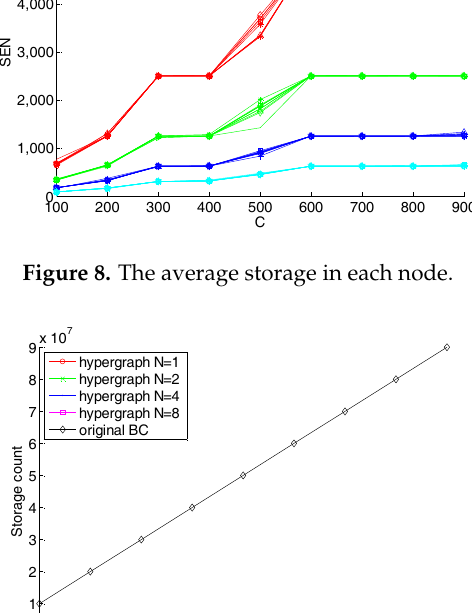
Figure 8. The average storage in each node. Figure 9. Memory comparison of proposed model with original blockchain model. Figure 9. Memory comparison of proposed model with original blockchain model. Figure 9. Memory comparison of proposed model with original blockchain